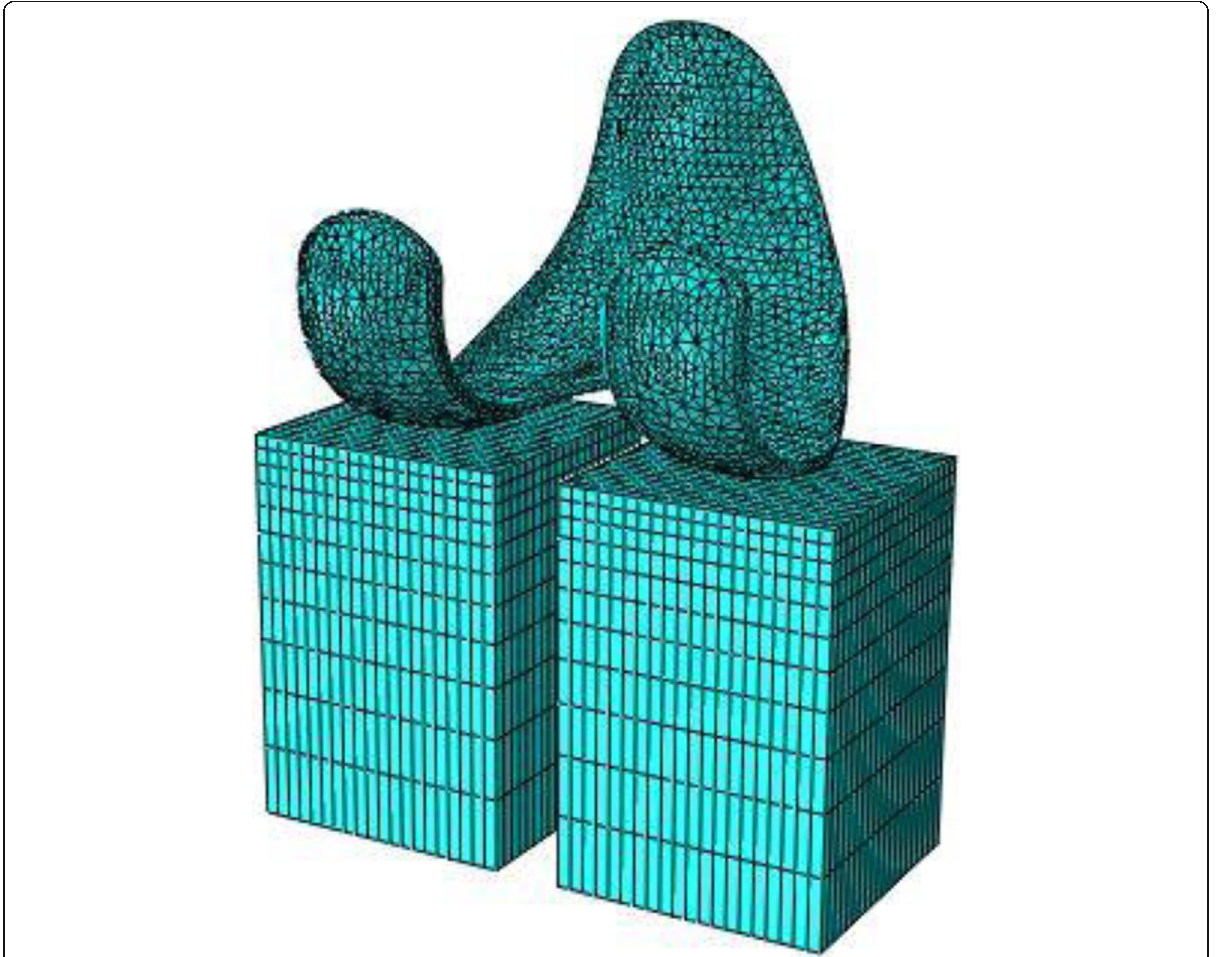
Fig. 1 Mesh of femoral component and